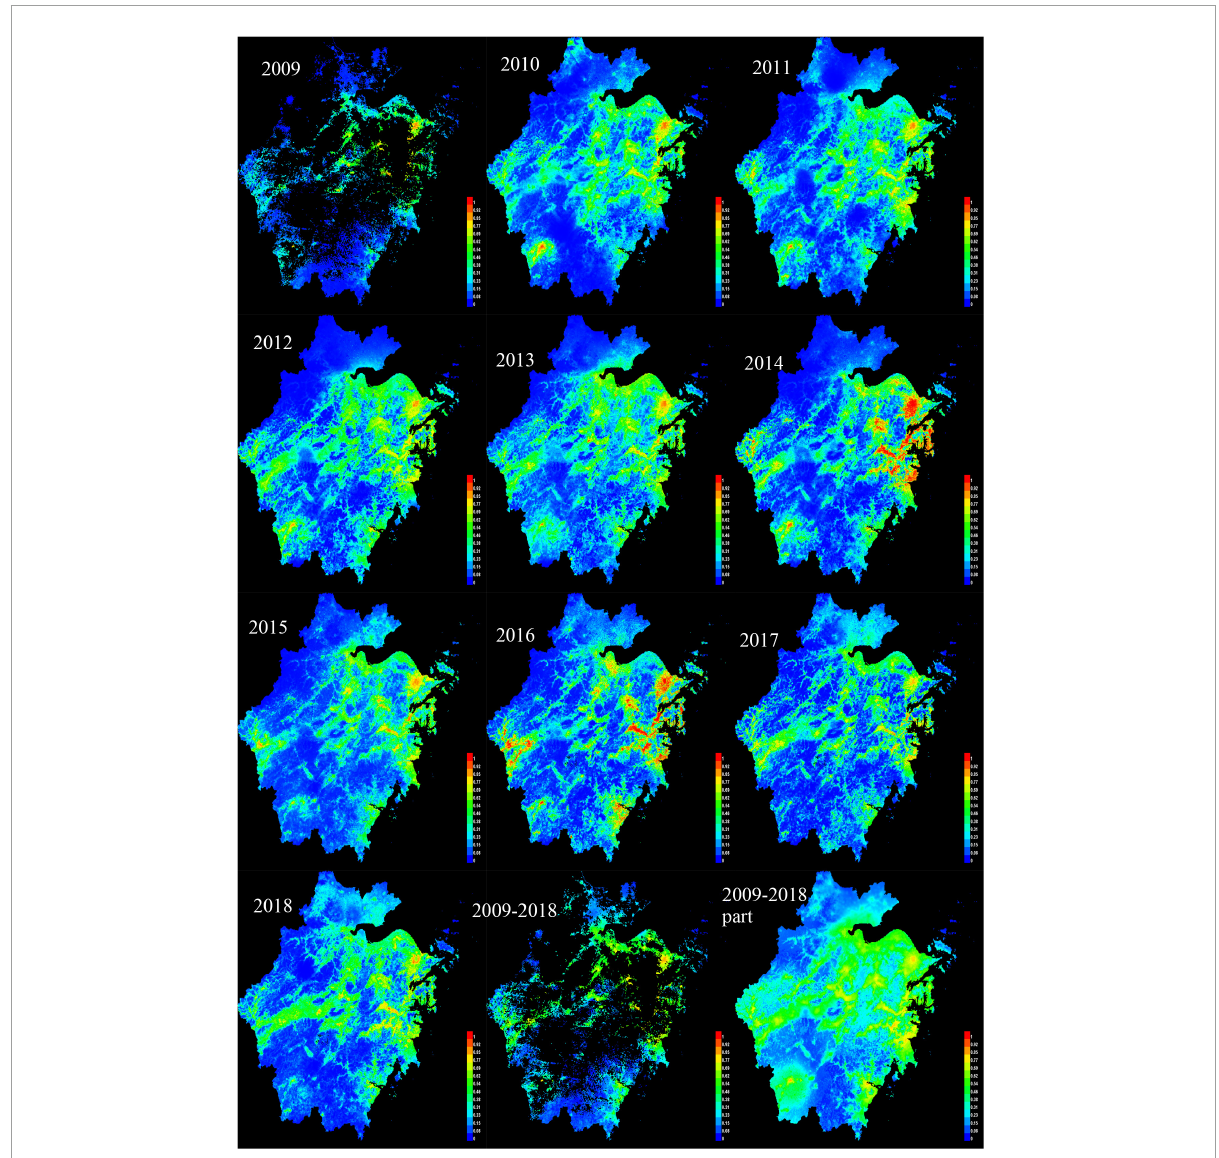
FIGURE2 The predicted potential risk map of HFRS from 2009 to 2018 in Zhejiang